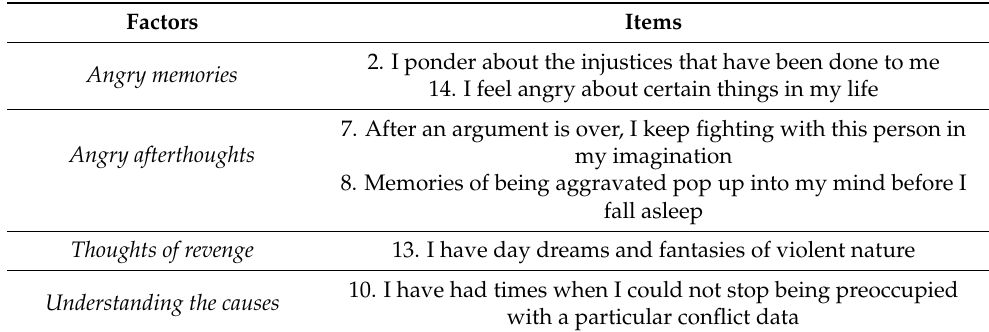
Table 1. Items withdrawn from ARS_19, according to the four factors.